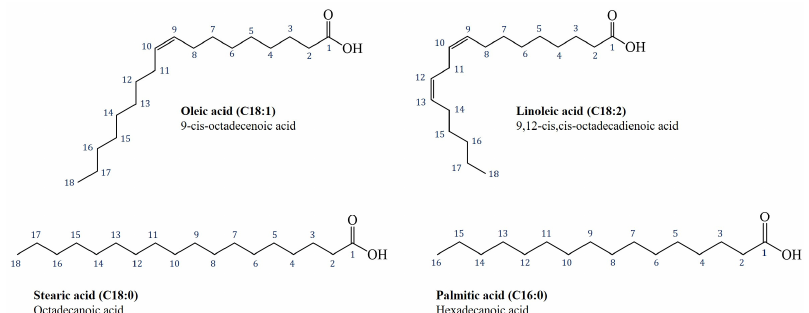
Figure 10. Structure and a clearer labeling (IUPAC system) for the carbon nuclei of the main and most abundant fatty acids in natural CB [51]. The carboxyl carbon for all FAs is denoted by the number one, and positions in the chain for other carbon atoms are denoted with reference to it. For simplicity, the molecules are represented as free fatty acids instead of their esterified form as TAGs. As can be seen from Table 3, for sample B in many areas of the spectrum there are two values of chemical shift for the same carbon of the various acids as a function of the acyl chain position ( sn -1,3 or sn -2) in the TAG. In particular, there are three regions of the 13 C NMR spectrum where this effect is much more noticeable: the region ranging from 33.80 ppm to 34.50 ppm, which is assigned to the C-2 carbons; the region from 127.70 ppm to 130.30 ppm assigned to the olefinic carbons of oleic and linoleic acids; and, finally, the region from 172.50 ppm to 173.60 ppm assigned to the C-1 carbonyls. Figure 11 shows these three enlarged areas of the 13 C spectrum in which the spectrum profile of natural CB is compared with that of modified sample B. For example, if we consider the region of carbons C-2 from 33.80 to 34.50 ppm (Figure 11a), for natural CB we can see only two signals: one at 34.08 ppm and one at 34.22 ppm assigned, respectively, to the C-2 of palmitic and stearic acids at the sn -1,3 position, and to C-2 of oleic and linoleic acids at the sn -2 position. These two peaks correlate to the H A proton in the HMQC map. Instead, in the spectrum of the modified sample B, in addition to the peaks already identified, two other well-defined signals with slightly different chemical shifts are seen: the first one at a lower frequency, 34.05 ppm; and the second at a higher frequency, 34.24 ppm. These two peaks have been assigned to C-2 carbons of oleic and linoleic acids in position sn -1,3, and to C-2 carbons of palmitic and stearic acids in position sn -2, respectively. Even in this case, the confirmation of the correct assignments is given by the correlation in the HMQC map between these signals and those belonging to the proton H A . The appearance of these extra signals in the 13 C spectrum of sample B compared to